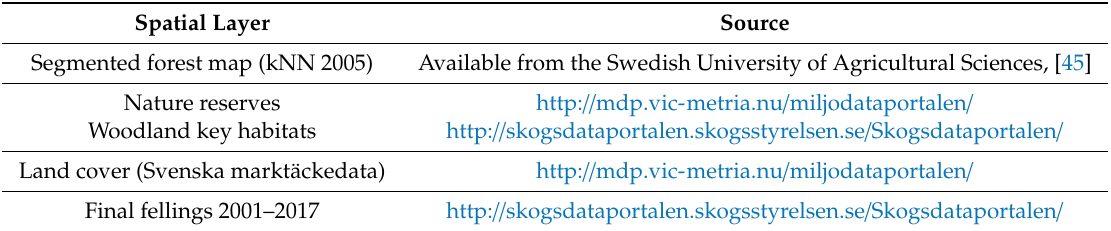
Table A1. Spatial layers used in the generation of the input